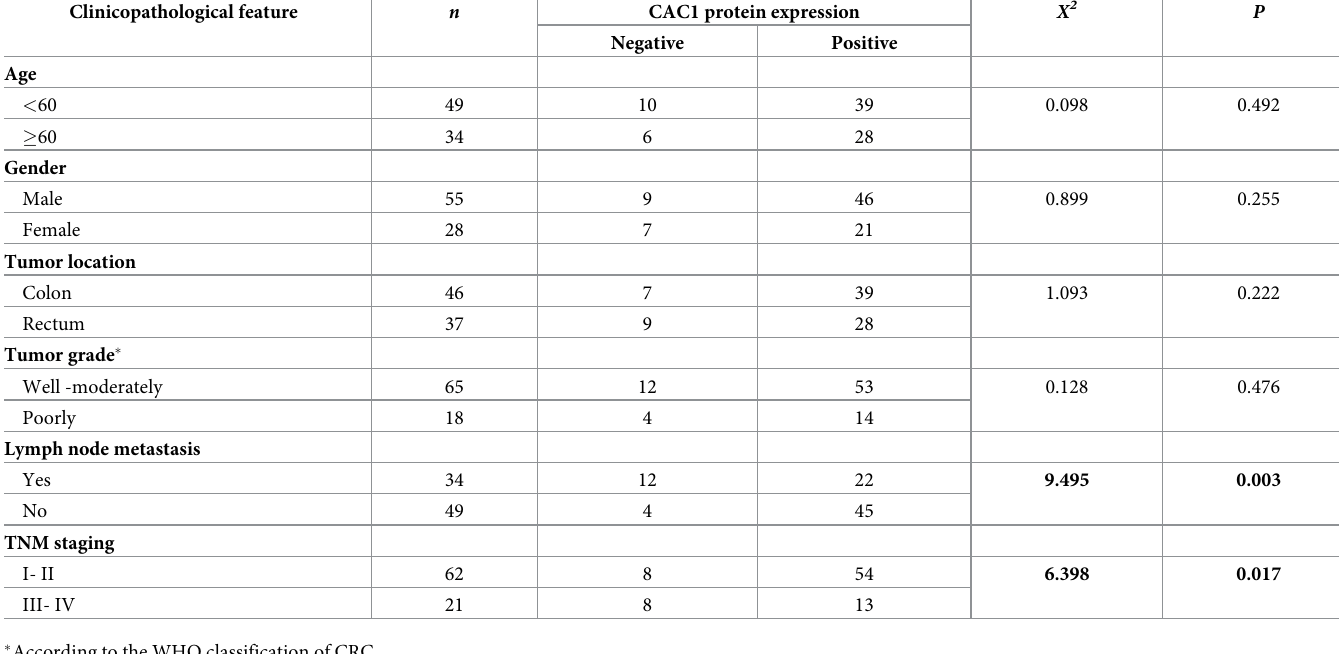
Table 1. Clinicopathological features of the 83 CRC patients and their